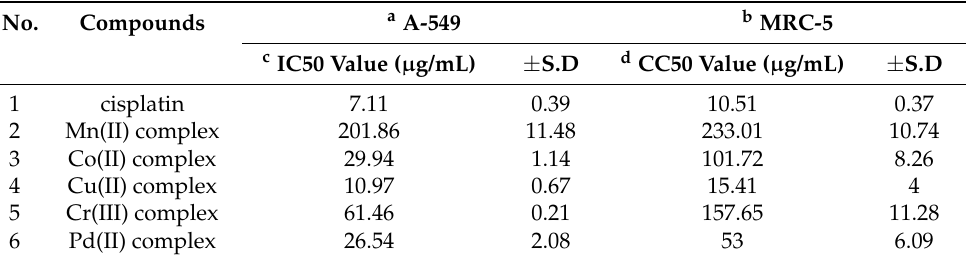
Table 5. The inhibitory effects (IC50%) (CC50%) of cisplatin compound and Mn(II), Co(II), Cu(II), Cr(III), and Pd(II) complexes against different types of cell lines. No.